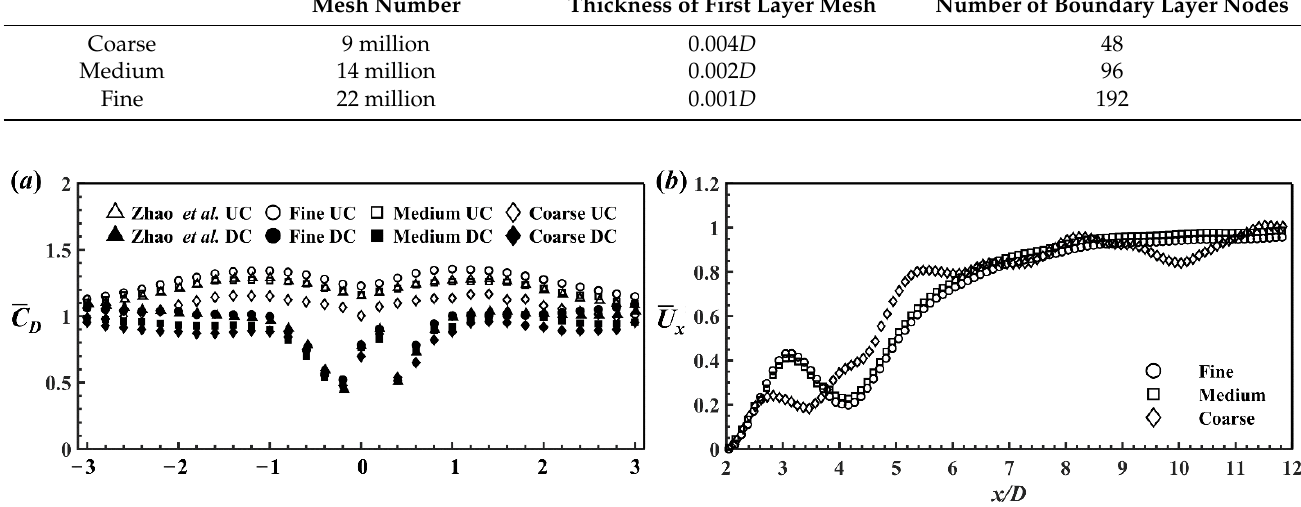
Figure 3. Comparison of mean drag coefficient ( a ) and mean streamwise velocity along the x axis ( b ) between the coarse, medium, and fine meshes.